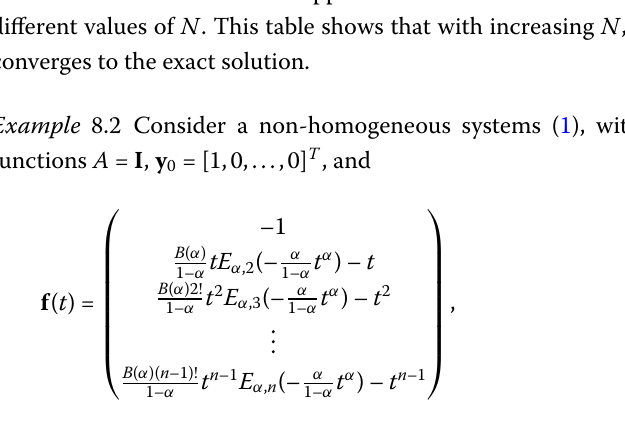
Table 1 The approximation and exact solution of Example 8.1 for α =